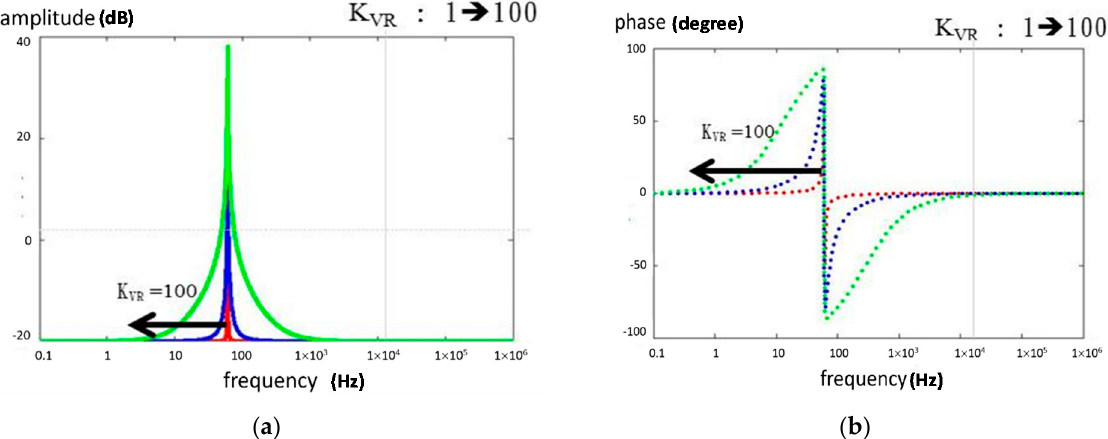
Figure 15. Variation of the voltage resonant coefficient K VR1 of the PR controller on ( a ) amplitude ( b ) phase.